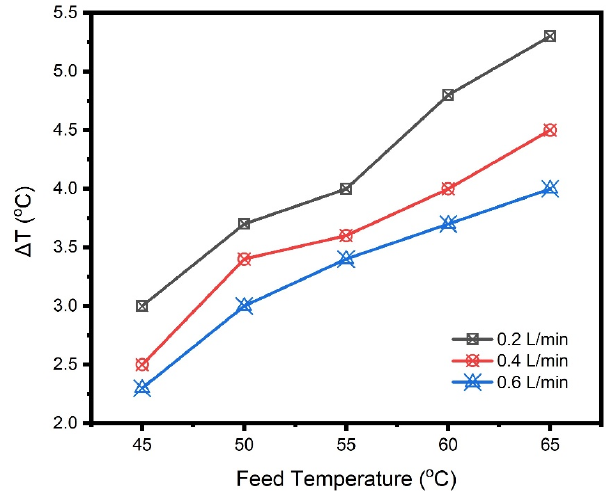
Figure 5. Variance between inlet and outlet feed temperatures versus the inlet feed temperatures for 35 g/L NaCl solution and 300 L/h sweep gas flow rate.